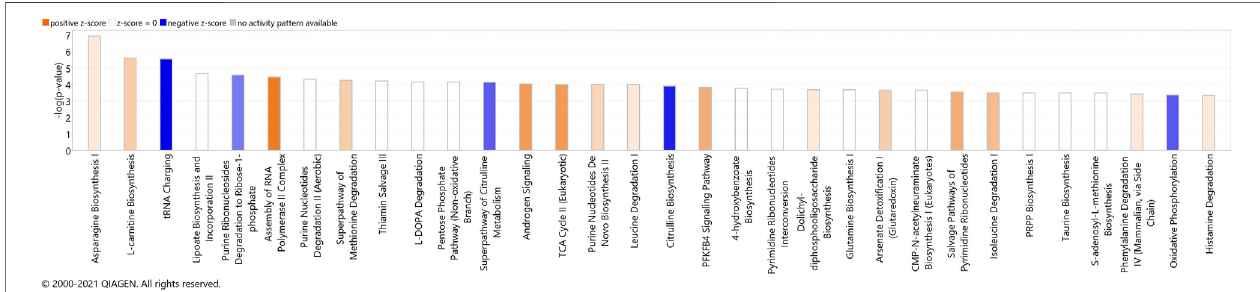
FIGURE 7 | Canonical pathways identi fi ed using IPA analysis, based on the meta-analysis. The bars represent the signi fi cance of the canonical pathway as calculated by a right-sided Fisher ’ s exact test. Therefore, the tallest bars represent the canonical pathways that are the least likely to have been identi fi ed due to molecules being in the canonical pathway by random chance. Canonical pathways which are likely activated (based on the pattern of differentially abundant proteins or metabolites) are presented in orange (positive z-score) and pathways that are likely inhibited are presented in blue (negative z-score).